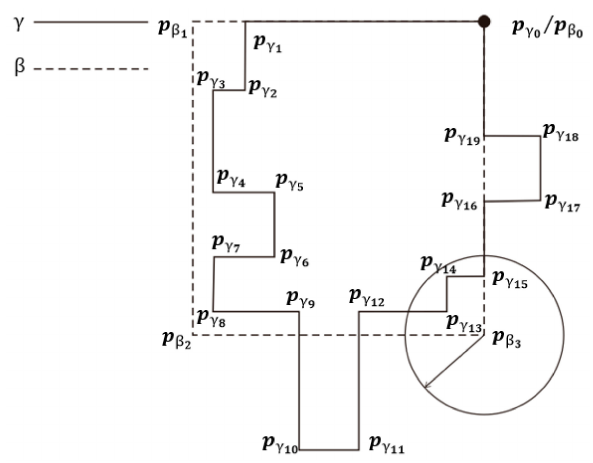
Figure 5. Illustration of the segmentation